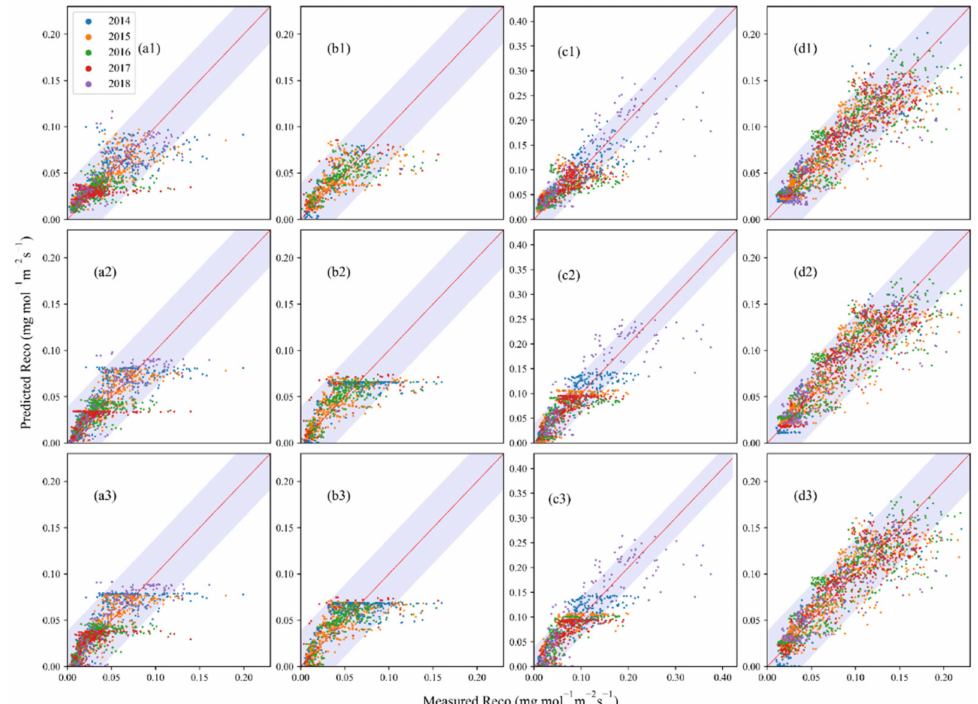
Figure 5. Performance of three temperature-only models at the four grasslands in different years. ( a1 – d1 ) are for Arrhenius model; ( a2 – d2 ) are for logistic model; ( a3 – d3 ) are for Gamma model; ( a1 – a3 ) are for SHB; ( b1 – b3 ) are for DRY; ( c1 – c3 ) are for TEMP; ( d1 – d3 ) are for MDW. The red solid lines are the 1:1 line. The shaded areas are the envelopes of confidence intervals at 95%.